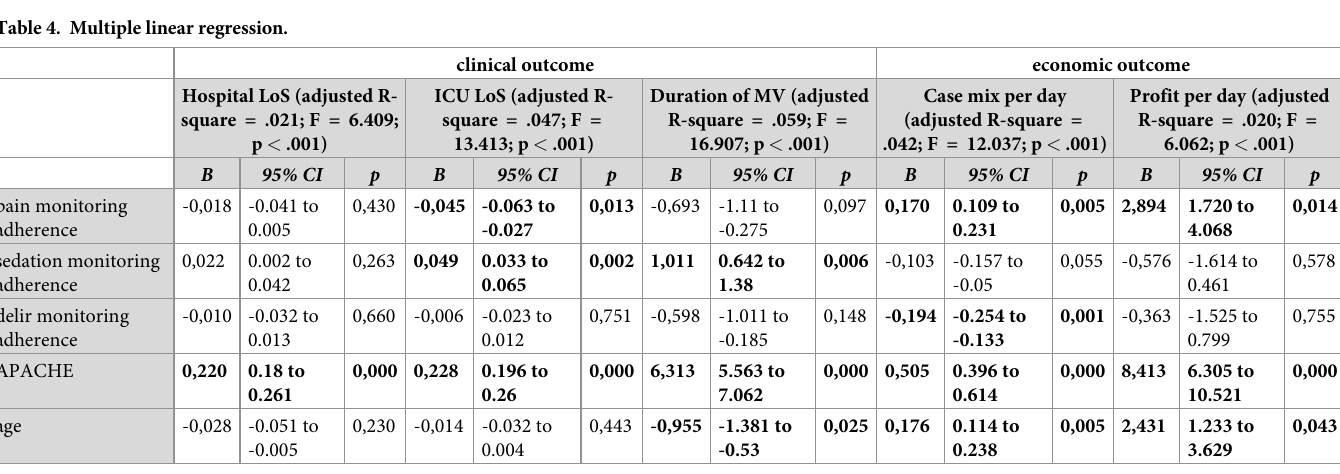
Table 4. Multiple linear